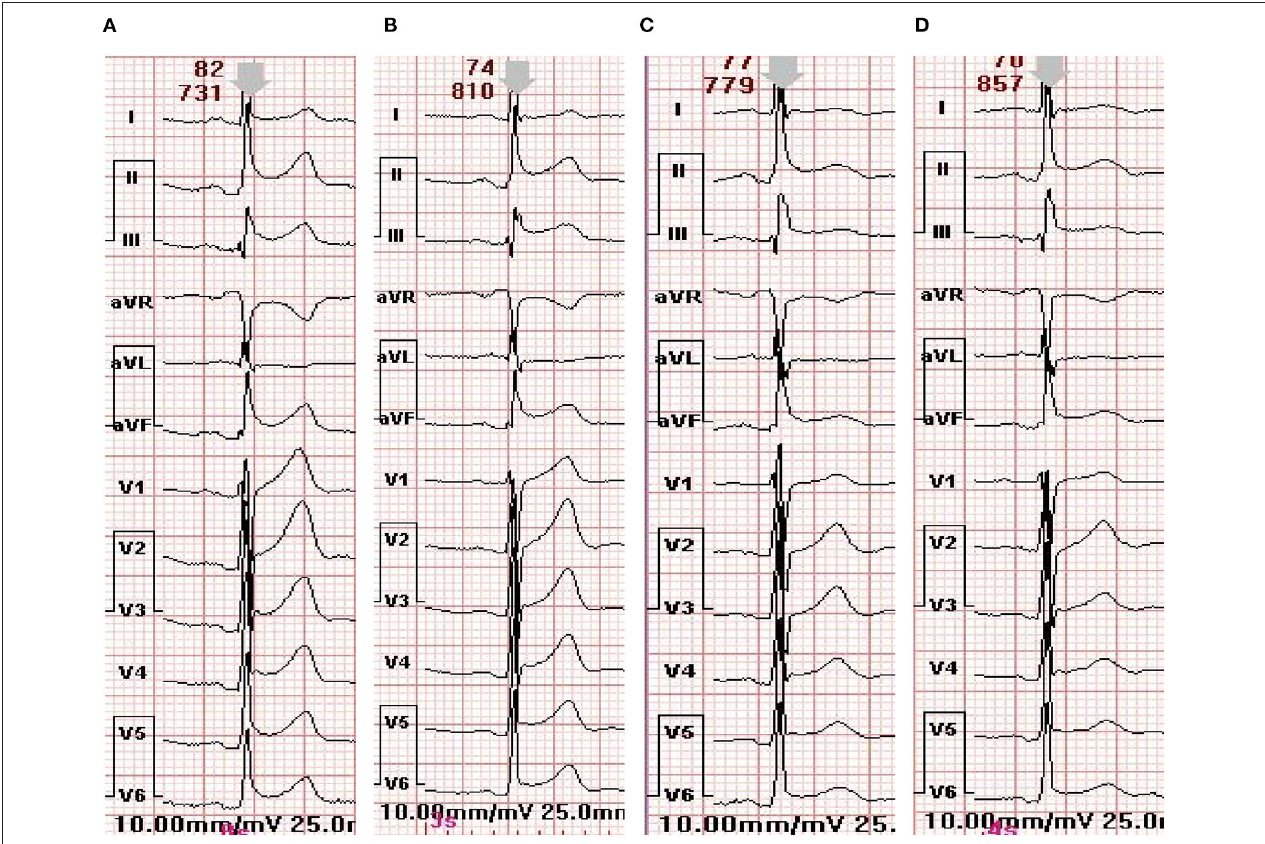
FIGURE 4 | ECG changes of patient 7 during hospitalization. (A) The electrocardiogram at admission. (B) The electrocardiogram on the first day of admission. (C) Electrocardiogram on the third day of admission. (D) The electrocardiogram before